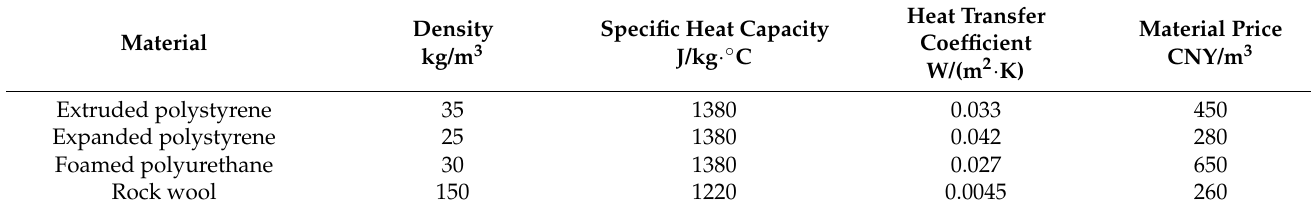
Table 4. The value of the attribute of the optimized